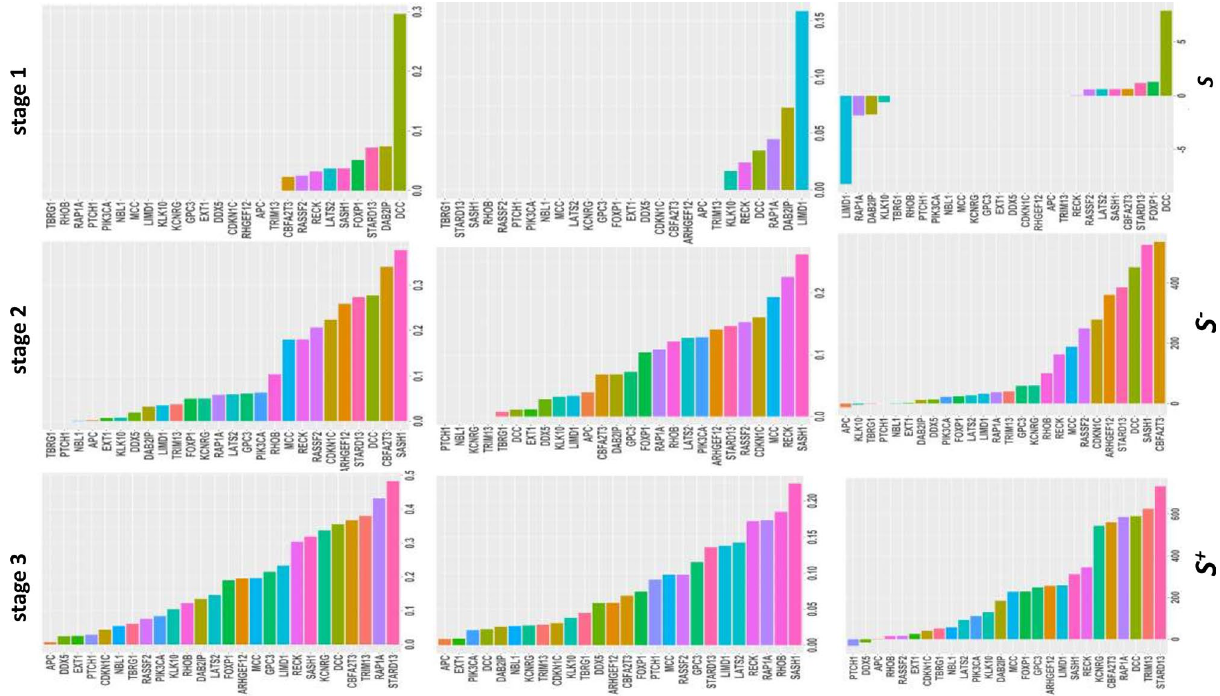
Figure 4. Histogram plots for S + , S − and S of TS genes. Correlation coefficients were used to measure roles of TS genes in regulation of expression of the other genes. TS genes with negative correlation coefficients is a threshold value with Bonferroni adjusted p < 0.05, see “Methods” for calculation of T value) have a negative role that up-regulates expression of genes while those with positive correlation coefficients role that down-regulates expression of the other genes. S -score is defined as sum of all correlation coefficients larger than or equal to a given positive threshold or less than or equal to a given negative threshold for a TS gene i : S i = (cid:31) m j 1 r ij || r | ≥ T where j =1, 2, ..., m and i = 1, 2, ..., n. Here n and m are numbers of DE and TS genes, = respectively. S + is proportion of sum of all correlation coefficients larger than or equal to a given threshold to sums of correlation coefficients larger than zero for a TS gene i : S + i Similarly,